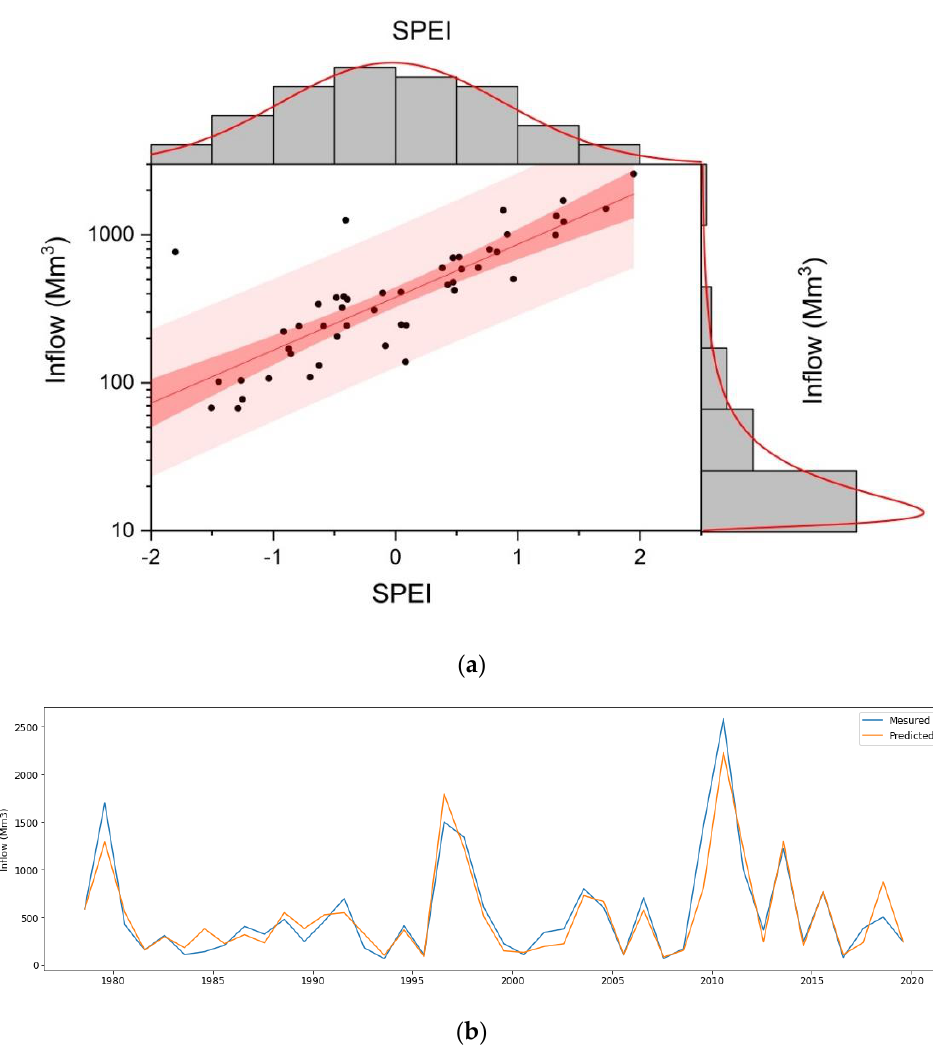
Figure 10. ( a ) Logarithmic fitting of inflow date with the monthly SPEI using bivariate distribution, ( b ). Observed and predicted inflow using the logarithmic fitting through semi-logarithm scale.